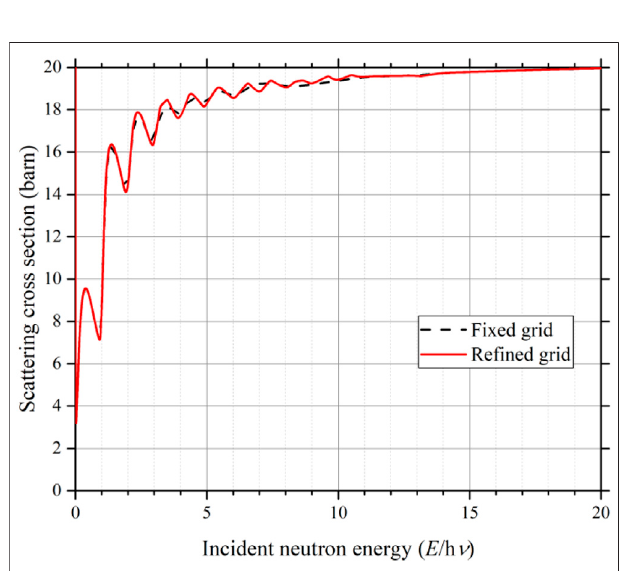
FIGURE 5 | Inelastic scattering cross section of δ -ZrH 1.5 as a function of energy.